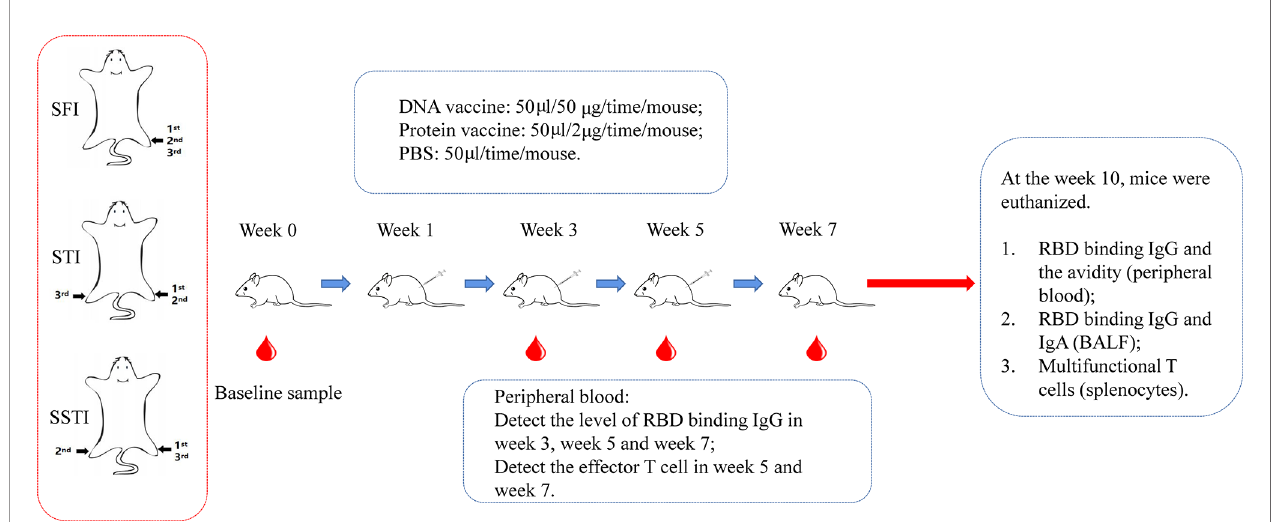
FIGURE 1 | The schematic illustration of experimental design. C57BL/6 mice were immunized with DNA vaccine or alum-adjuvanted protein subunit vaccine via 3 different inoculation strategies (SFI, STI and SSTI) for 3 times at an interval of 2 weeks. Peripheral blood samples were collected at baseline and 2 weeks post each immunization. 5 weeks after the last vaccination, mice were euthanized. Mouse serum, splenocytes and BALF were collected for measurements of the antigen- speci fi c immune responses. SFI, site- fi xed inoculation; STI, simpli fi ed translocating inoculation; SSTI, successively site-translocating